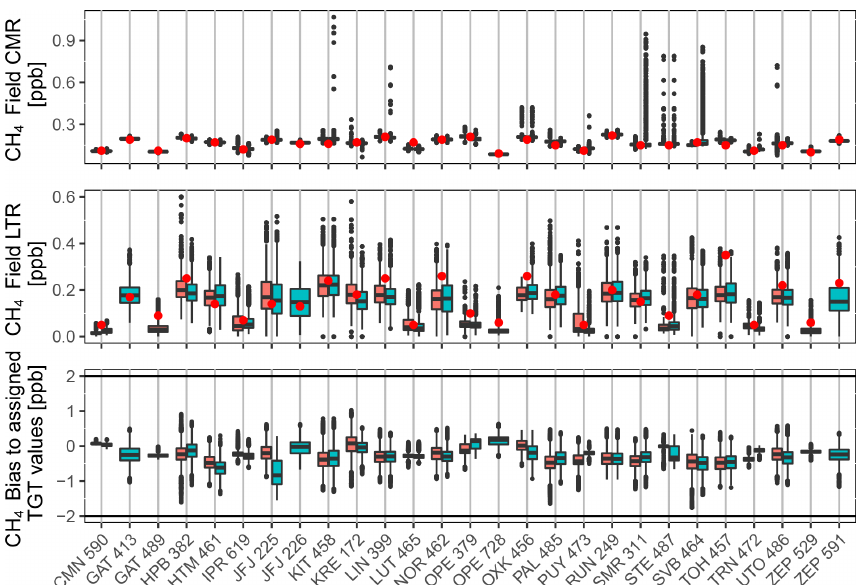
Figure 17. Uncertainties and bias to the short-term target for CH 4 , defined as in Fig. 12. The red dot shows the minute CMR and LTR from the MLab initial tests. The left box (pink) is calculated using data from the year prior to labeling. The right box (blue) is calculated using data from March 2019 to March 2020. For GAT, 489 was prior to 413. For JFJ, 226 replaced 225. At OPE, 729 is running in parallel with 379. At ZEP, 529 was prior to 591. The x axis shows the site trigram and ICOS ID of the analyzer. The black lines in the bias plot show the WMO compatibility